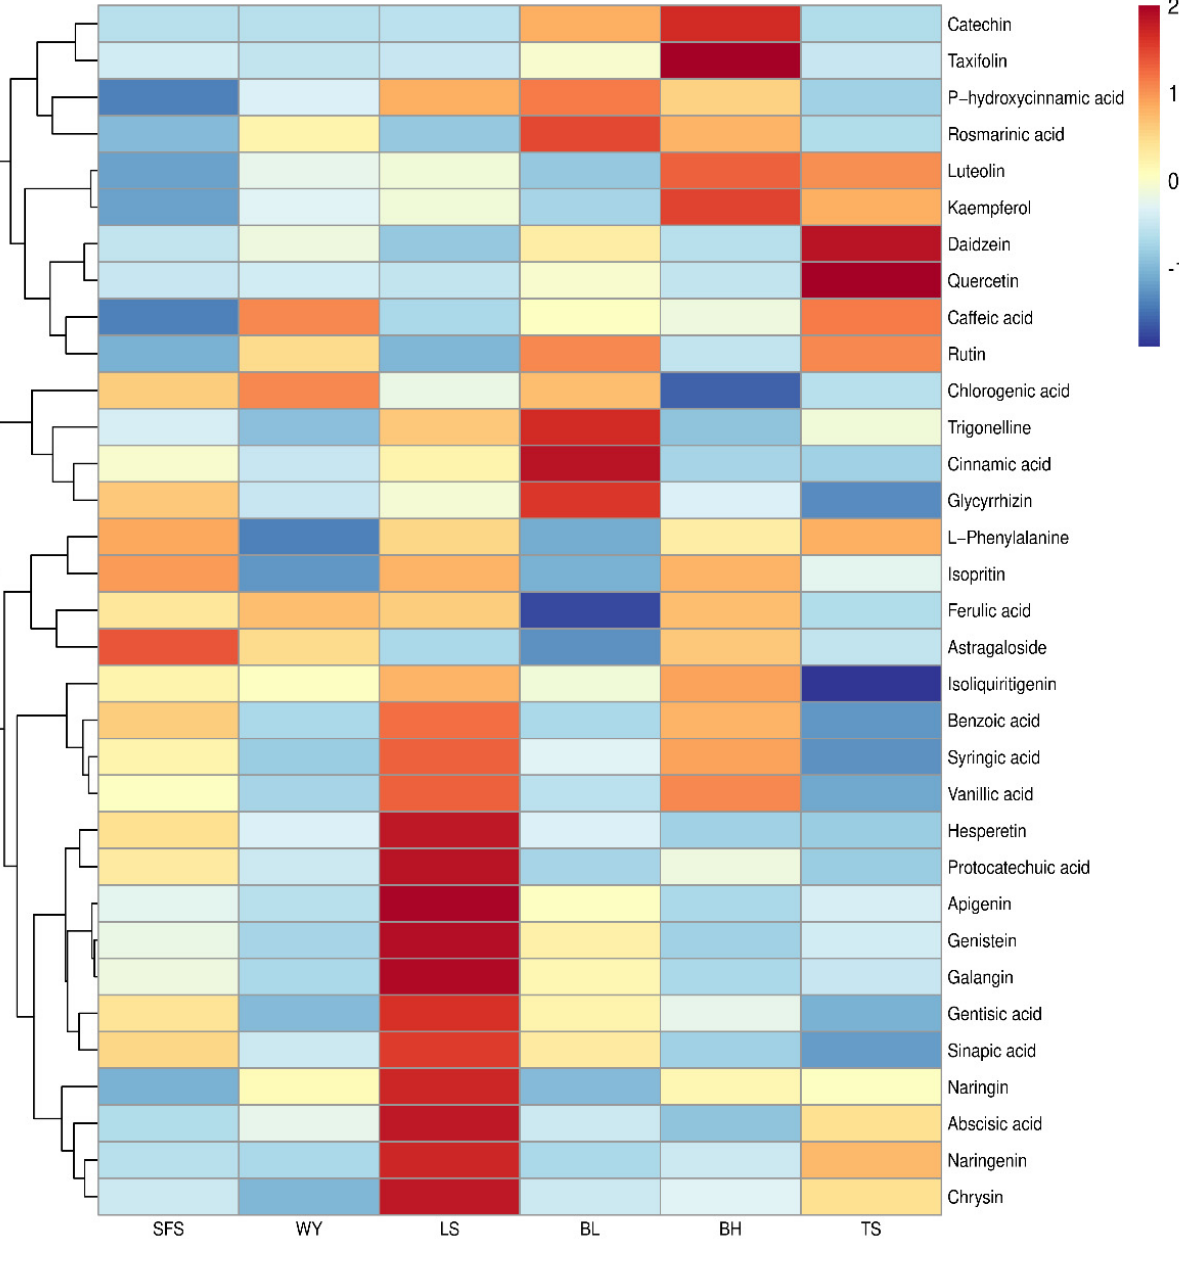
Figure 6. Distribution of secondary metabolites at different latitudes of T. amurensis . Heat map visualization of flavonoids at different latitudes of T. amurensis . Data of the content value of each compound were normalized to complete linkage hierarchical clustering. Red indicates high abundance, whereas low relative compounds are blue (color key scale above heat map).